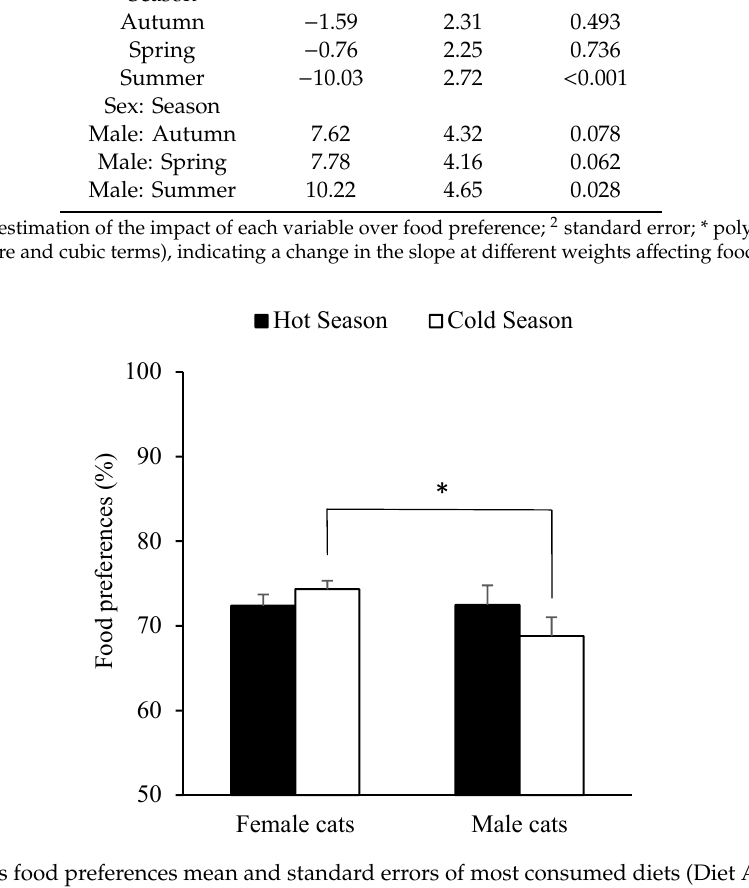
Figure 4. Cat’s food preferences mean and standard errors of most consumed diets (Diet A) after two feeder 20-h preference tests according to animal’s sex (females or males) and climate season (hot or cold). * p < 0.05.